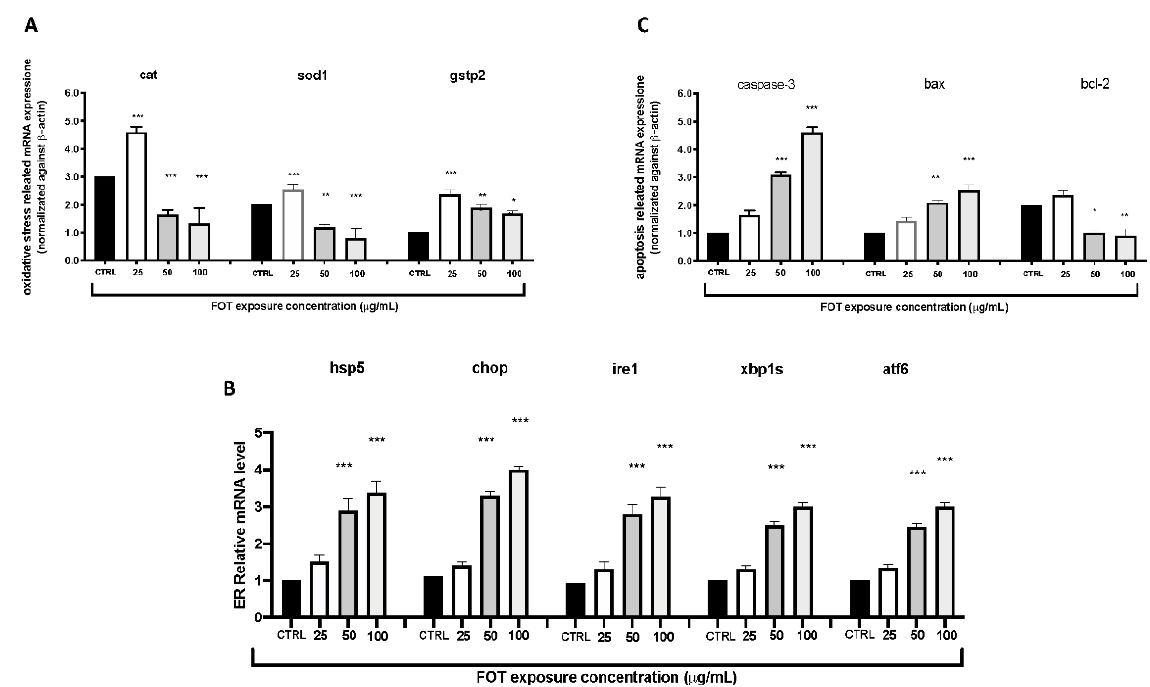
Figure 4. The fotemustine exposure effects on oxidative ( A ), apoptosis ( B ), and ER stress ( C ) pathway-related genes on zebrafish embryos. The results are expressed as mean of three independent experiment data. The expression levels of mRNA are represented as the fold change from the CTRL group. * p < 0.05, ** p < 0.01, *** p < 0,001 versus CTRL.